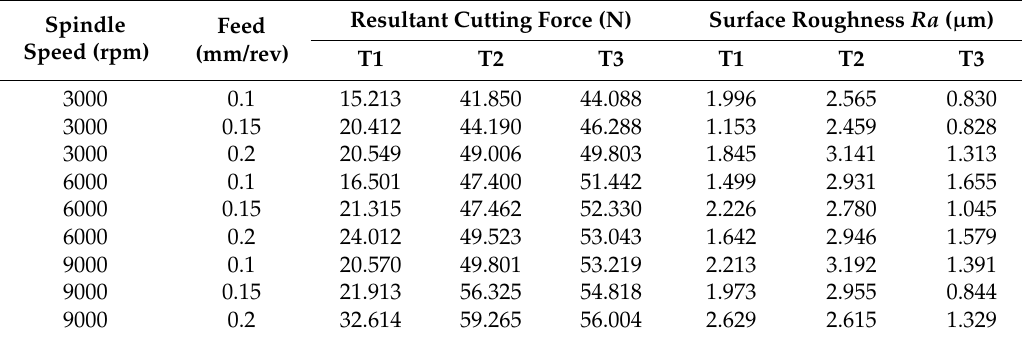
Table 4. Resultant cutting forces and surface roughness values.